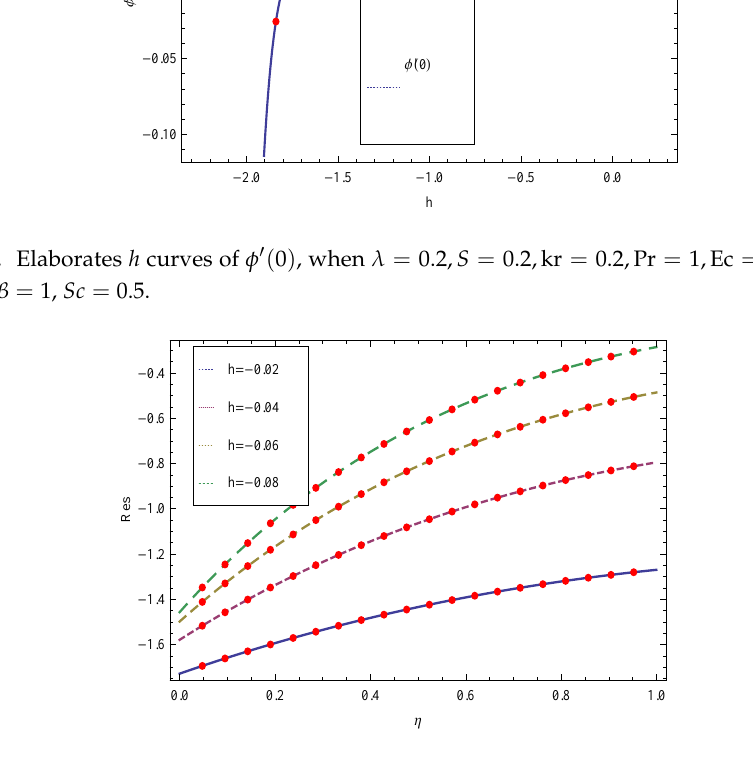
Figure 29. Illustrates h curves of the residuals for the velocity profile f ( η ) , when λ = 0.6, S = 0.6, Kr = 0.4, Pr = 1, Ec = 0.4, Nb = 0.6, Nt = 0.5, Sc = 0.5, β = 1.